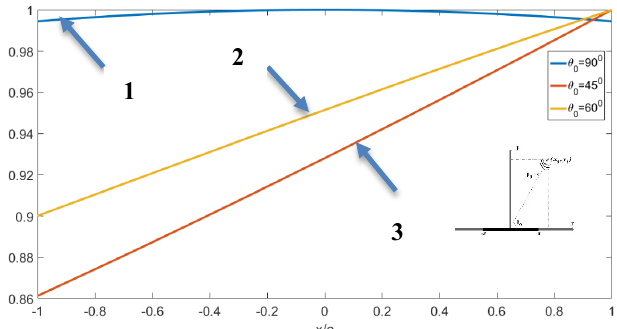
Figure 7: The Amplitude of the Total Electric Field 𝐸Q⃗ AN for 𝑎 = 3 , 𝜖 = 2𝜋 , 𝑥 = 0 and 𝑦 = 2𝜋 F F In Fig. 8 and 9, Bi-static RCS with different 𝜖 = 𝑘𝑎 values are shown. The location of the source line and the angle with Figure 10: The normalized Fractional Current Density respect to the strip are given in order. 1 is responsible |𝑓y Y2$ (𝜉) | for 𝜖 = 𝜋 and 𝜌 for 𝜃 = 90 F , 𝑥 = 0 , 𝑦 = 𝜖 . 2 is responsible for 𝜃 = 90 F , F F F F 𝑥 = 0 , 𝑦 = 20𝜖 . 3 is responsible for 𝜃 = 45 F , 𝑥 = 3𝜖 , F F F F 𝑦 = 3𝜖 and 4 is responsible for 𝜃 = 60 F , 𝑥 = 3𝜖 , 𝑦 = F F F F 3√3𝜖 .